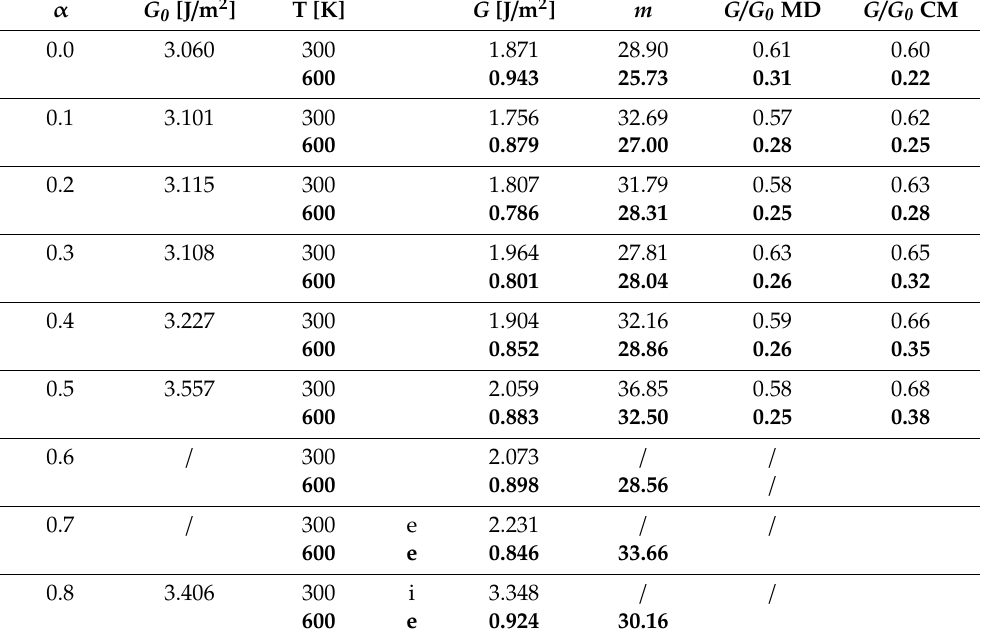
Table 2. Energy release rate and thermal activation of dislocation emission < 111 > {112}. The degree of thermal activation m in MD at temperature T is evaluated using Equation (3), where G is determined using the threshold values K A (t) from Table 1 and the evaluation of G 0 uses the threshold values K A (t) for 0 K from [6]. The last two columns present the relative ratios G / G 0 at 300 K and 600 K (bold) from MD and as predicted by continuum model (CM) respectively, using G 0 according to [5], m = 31.7 for 300 K and m = 29.2 for 600 K in Equation (3). The letters “e” and “i” in the fourth column denote the crack extension and crack initiation, respectively. α G 0 [J / m 2